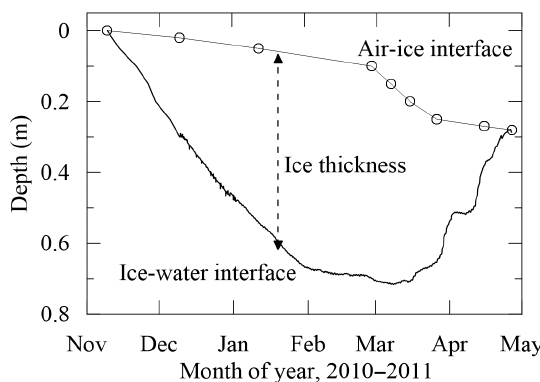
Figure 2. The observed lake ice thickness evolution over the whole 2010–2011 ice season. The open circles denote the observed loca- tion of the ice surface, and the solid lines connecting the circles denote the linear